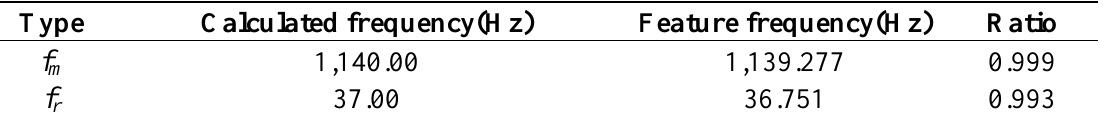
Table 2. Ratios of different frequency components to the feature